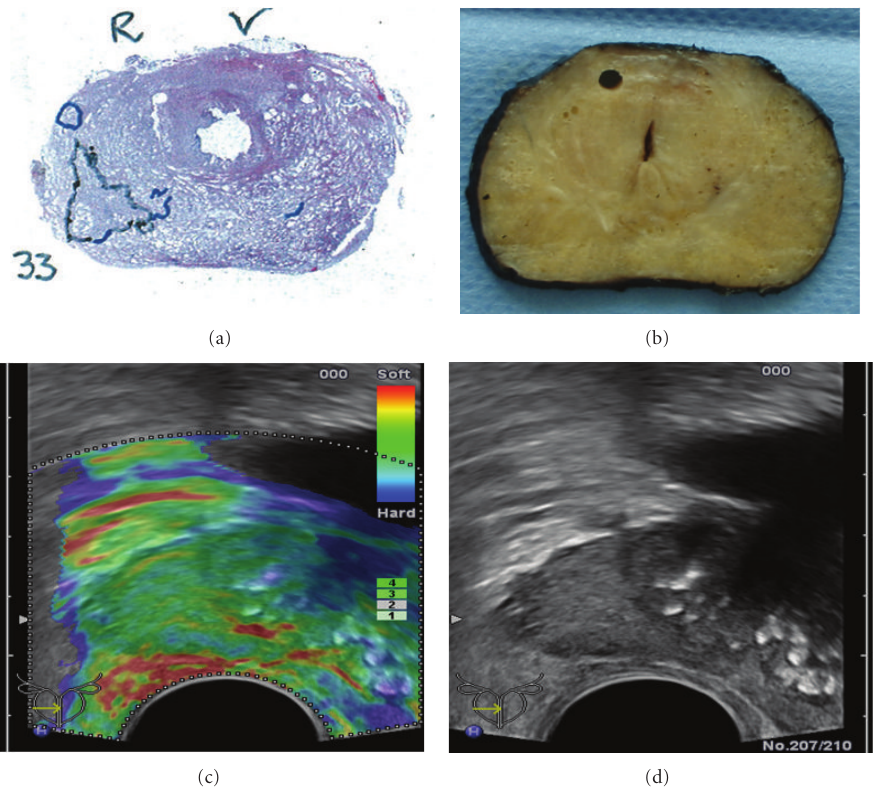
Figure 6: Outlined sparse cancer lesion PZ base right on whole-mount step section (a), no suspicious changes on macroscopic specimen (b), elastogram (c), and grey-scale ultrasound